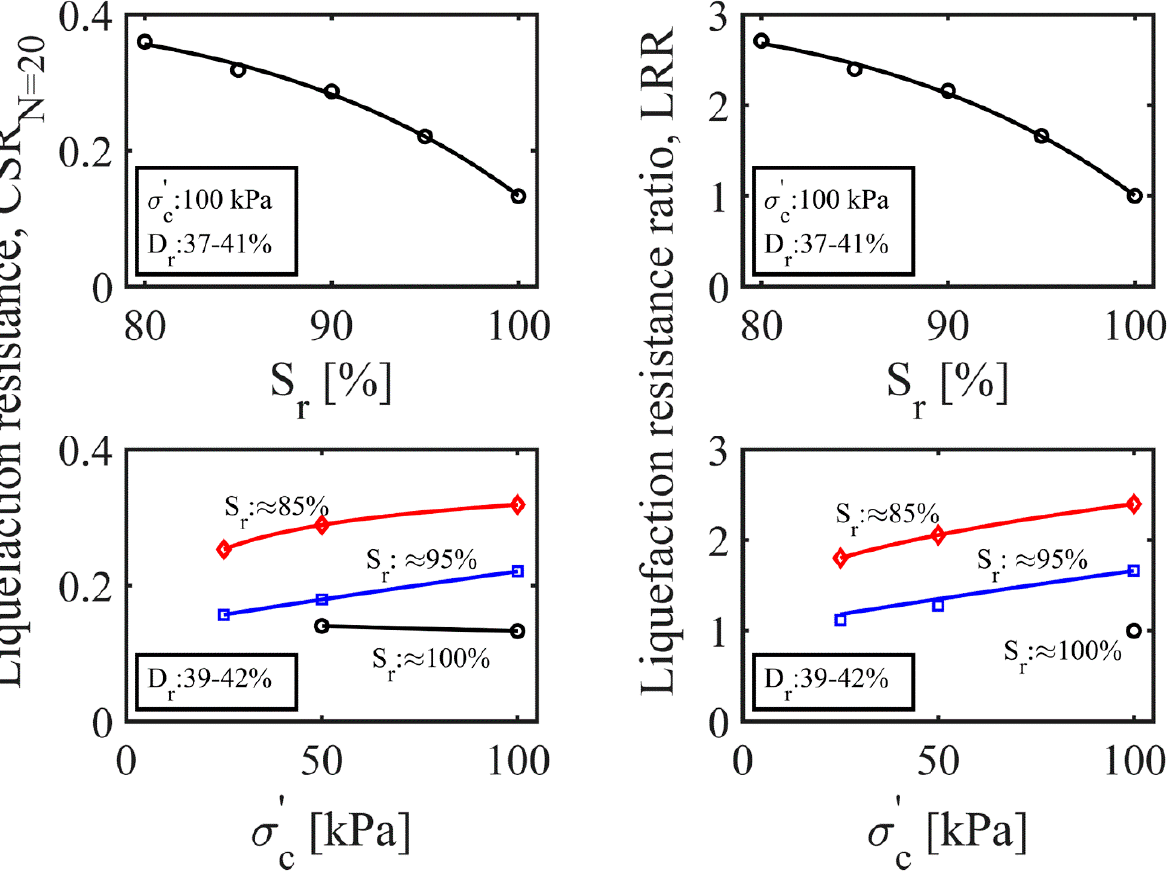
Figure 12. Variation in liquefaction resistance and liquefaction-resistance ratio with the degree of saturation and effective confining stress.